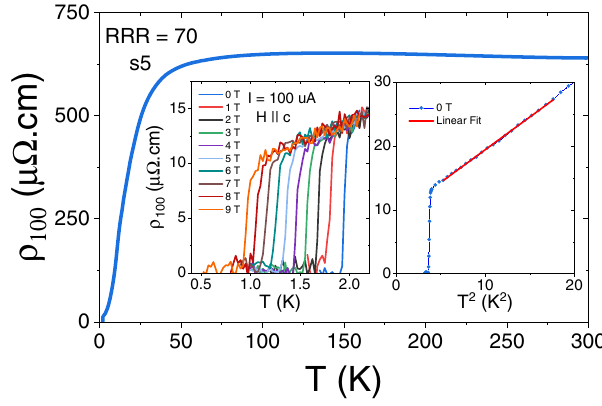
Fig. 3 Electrical resistivity of UTe 2 . Electrical resistivity of UTe 2 (sample s5) as a function of temperature with current along the a axis. Inset shows the low-temperature behavior under magnetic fi elds applied along c